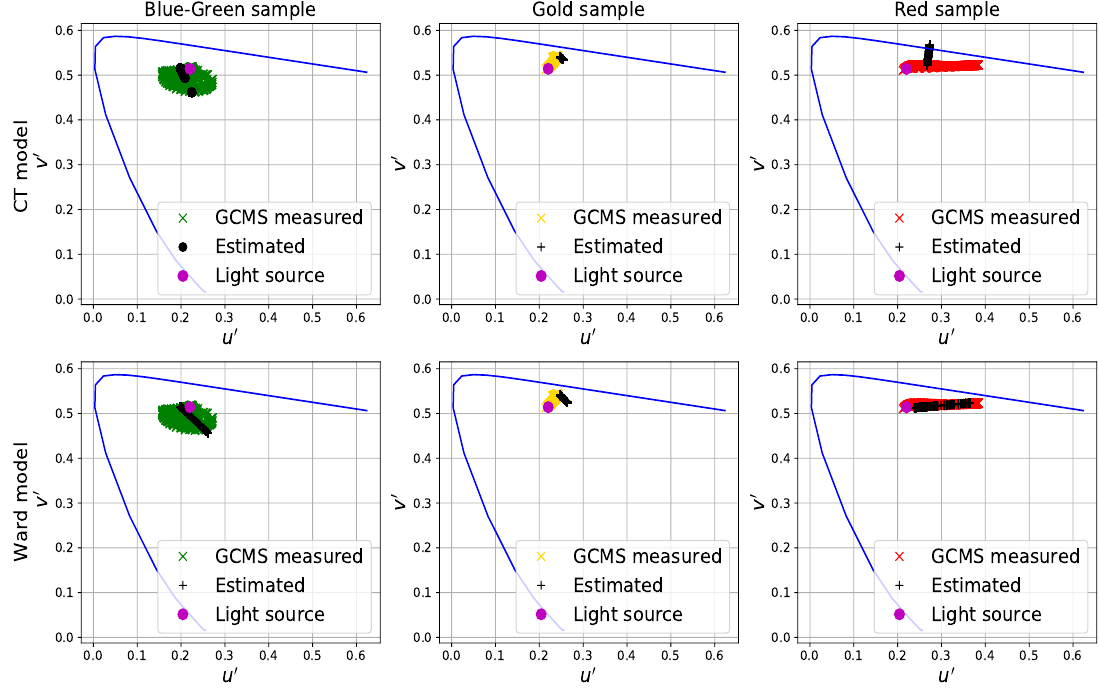
Figure 8. CIE1976 u (cid:48) v (cid:48) uniform chromaticity coordinates calculated using Equation (12) for all the samples measured with GCMS and estimated from reflection models trained using the dataset obtained from our measurement setup with one illumination direction ( θ L = − 45 ◦